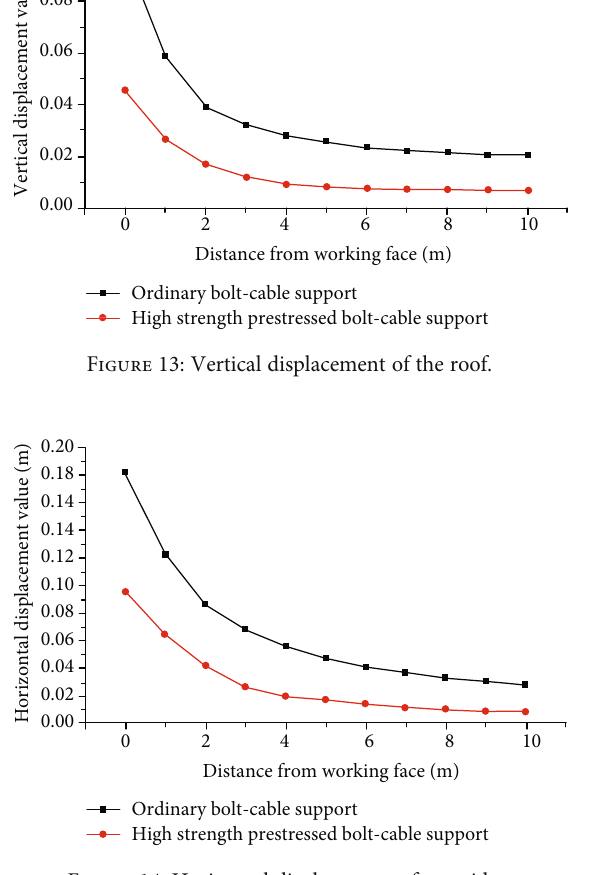
Figure 14: Horizontal displacement of two sides.